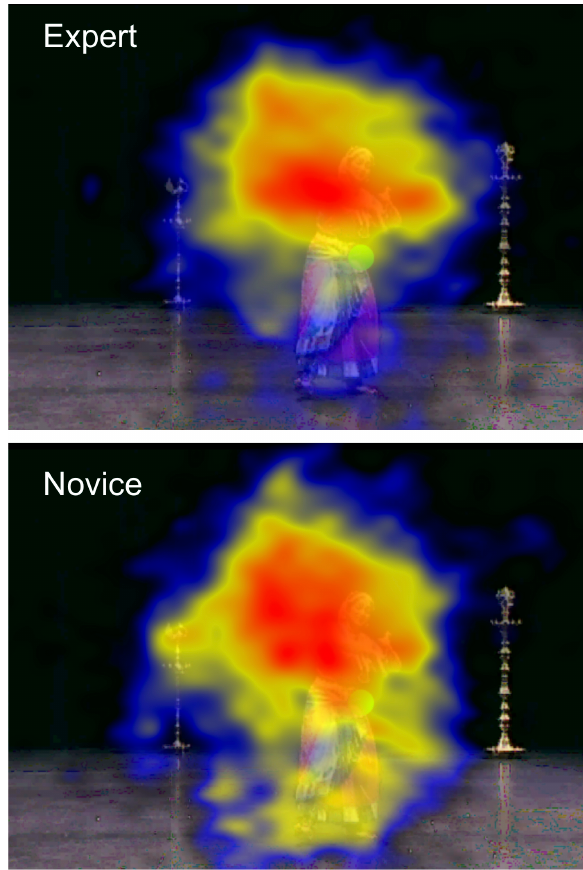
Figure 6. Heat maps showing the relative dispersion of fixations for experts and novices. Red areas depict higher dwell time; blue depicts lower dwell time.